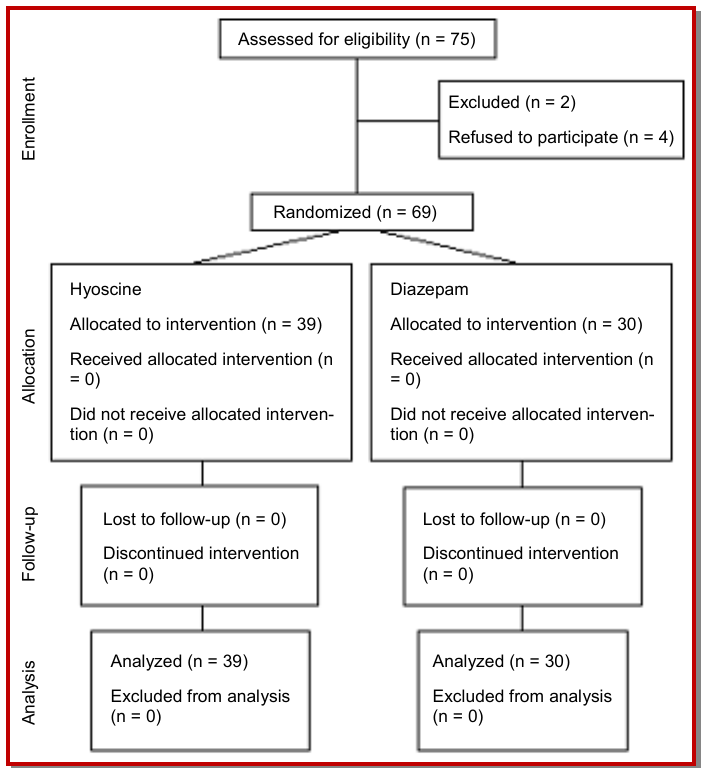
Figure 1: CONSORT flowchart of studied